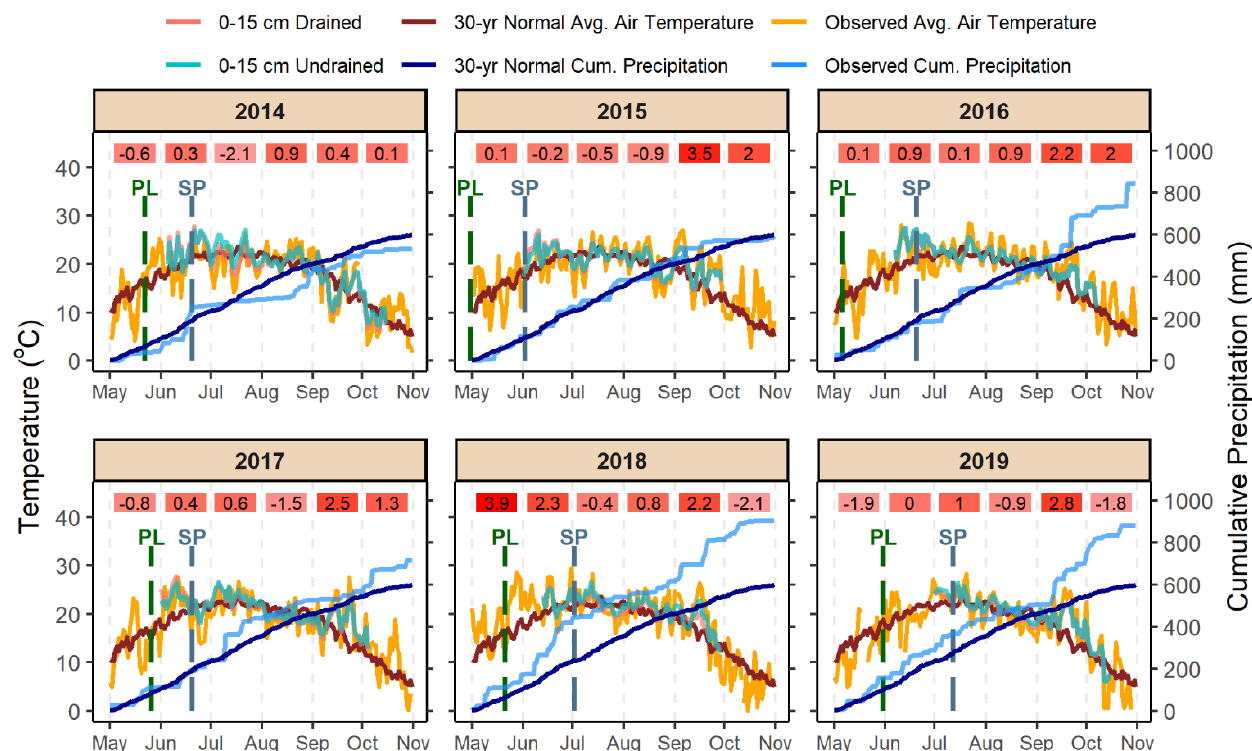
Figure 2. Observed daily average soil temperature at 0–15 cm for drained and undrained soils, mean daily air temperature (°C), 30-yr normal daily mean air temperature (°C), and cumulative and 30-yr normal cumulative precipitation (mm) for the 2014 to 2019 growing seasons. Nitrogen fertilizer applications are noted with dashed lines, green for at-planting (PL) and grey for the split (SP). Red-shaded boxes represent the monthly departure from normal for air temperature (°C).